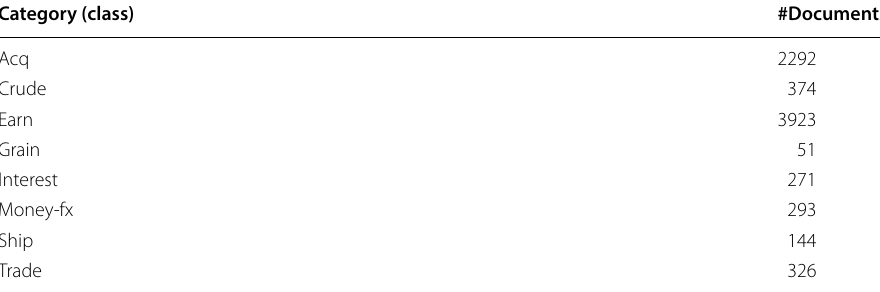
Table 4 Category distribution for the R8 collection